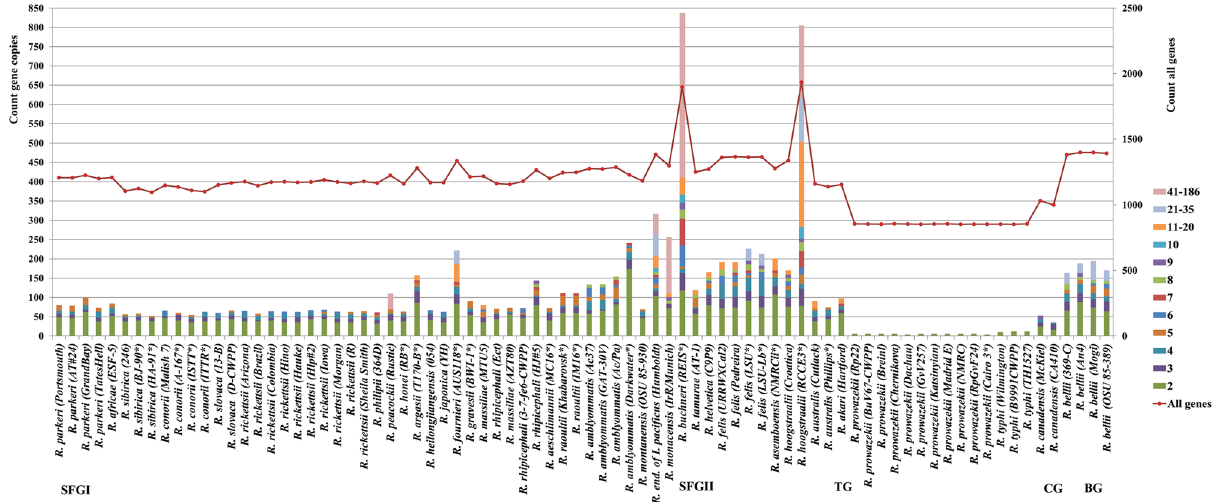
Figure 4. Distributions of gene proliferations identified in the pan-chromosome across 34 Rickettsia spp. (80 strains or chromosomes). The x-axis represents the 80 Rickettsia chromosomes examined. The left y-axis shows the total number of gene copies present in each chromosome. For each chromosome, colours indicate the numbers of genes according to their copy counts (from 2 to 186). The right y-axis displays the total gene count per chromosome.